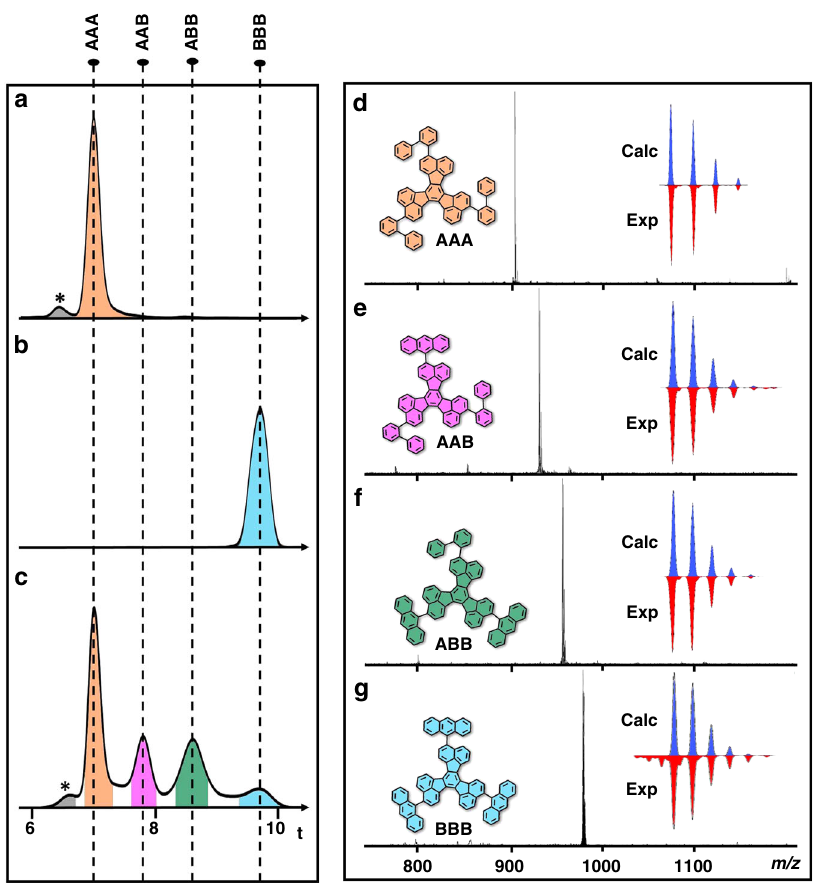
Fig. 5 HPLC/MS analysis of the cyclotrimerization products. a HPLC pro fi le of trimer AAA as obtained. The corresponding tetramer AAAA is marked with asterisk; b HPLC pro fi le of trimer BBB as obtained; c HPLC pro fi le of reaction mixture of combinatorial assembly of segment A and B in a 1:1 ratio showing formation of four trimers. The corresponding tetramers are marked with asterisk; d – g MS analysis of the separated trimers. Experimental and theoretical isotopic distribution are shown in inset. HPLC separations are performed on COSMOSIL-5PBB column 10 ×250 column (eluent toluene/MeOH 3:2, fl ow rate 5mLmin − 1 , t = 40°C, detection at 380